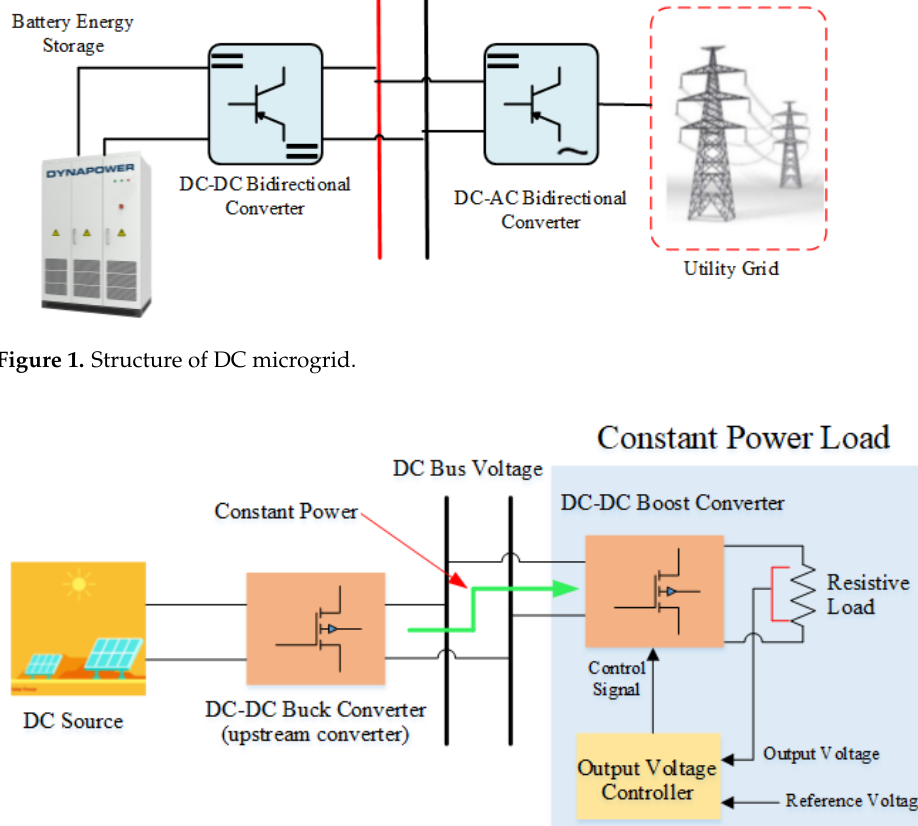
Figure 2. A cascaded structure of a buck converter feeding a voltage-controlled boost converter (operating as a CPL).